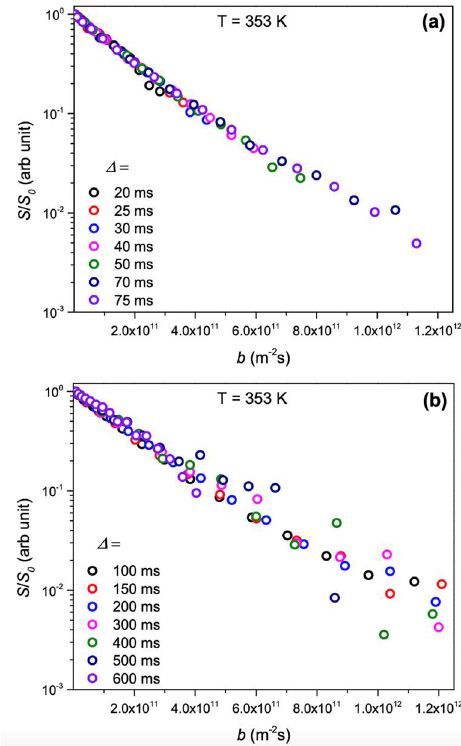
Figure 21. Signal Attenuation plots for single crystalline Li 6.5 La 3 Zr 1.5 Ta 0.5 O 12 (LLZTO) at diffusion times ( a ) from 20–70 ms and ( b ) from 100–600 ms. [74]